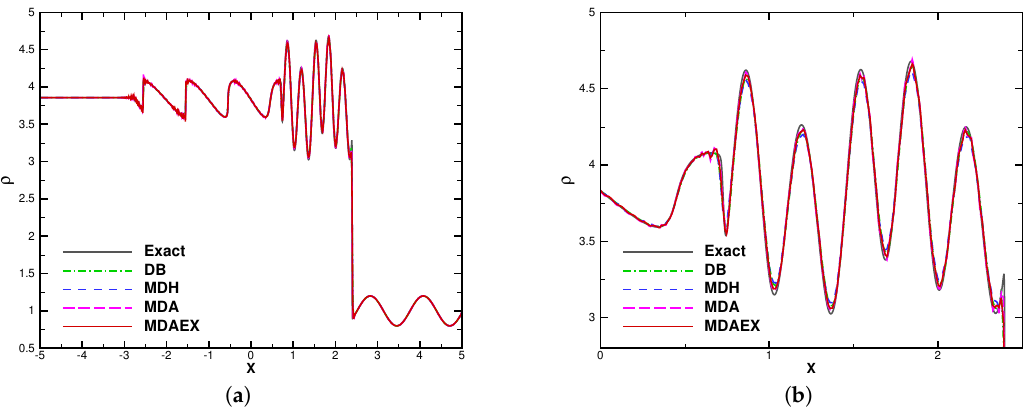
Figure 11. Density solution for the one-dimensional Shu–Osher problem with 200 elements at t = 1.8, P 4. ( a ) Overview; ( b ) zoomed in results.